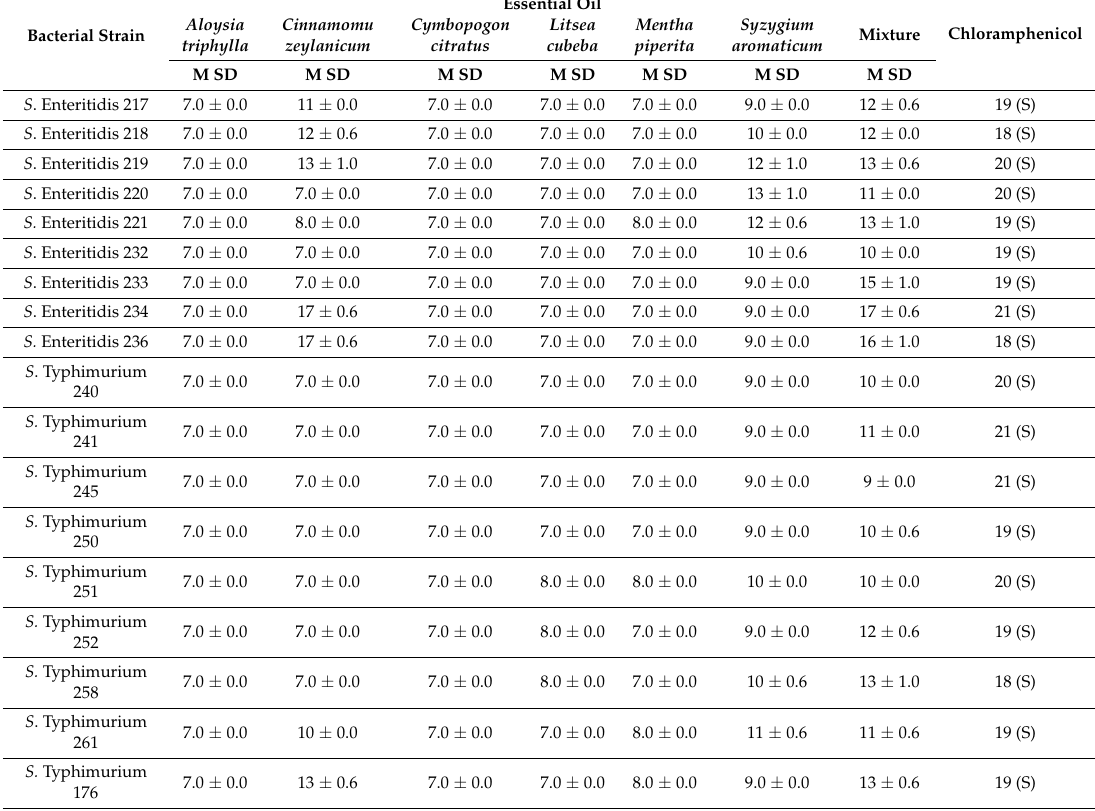
Table 2. The growth inhibition zones (expressed in mm) obtained testing the selected Salmonella Enteritidis and Salmonella Typhimurium strains against the assayed EOs and the mixture. Essential Bacterial Strain